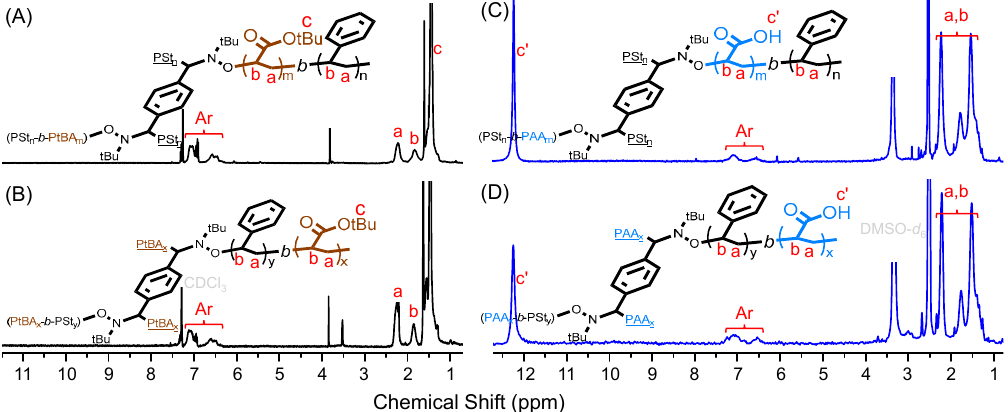
Figure 6. 1 H NMR (400 MHz) spectra of μ -star copolymers: ( A ) (PSt) 2 - μ -(PtBA- b -PSt) 2 and ( B ) (PtBA) 2 - μ -(PSt- b -PtBA) 2 in CDCl 3 ; ( C ) (PSt) 2 - μ -(PAA- b -PSt) 2 and ( D ) (PAA) 2 - μ -(PSt- b -PAA) 2 in DMSO-d 6 .